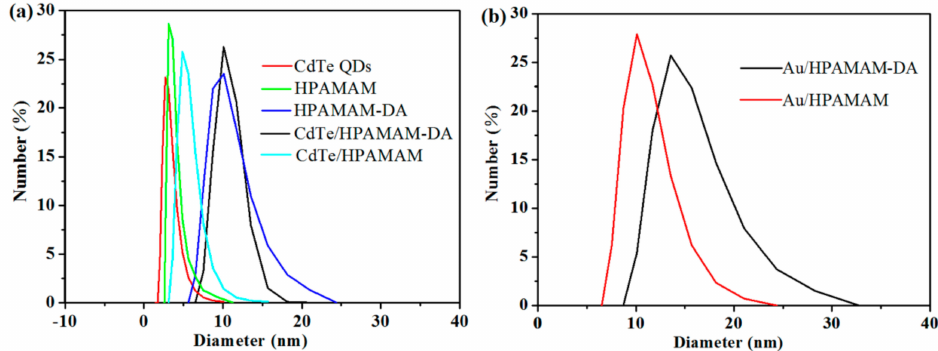
Figure 9. Size distributions of ( a ) CdTe QDs, HPAMAM, HPAMAM–DA, CdTe / HPAMAM–DA, CdTe / HPAMAM, and ( b ) Au / HPAMAM–DA, Au / HPAMAM nanocomposites, measured by DLS.